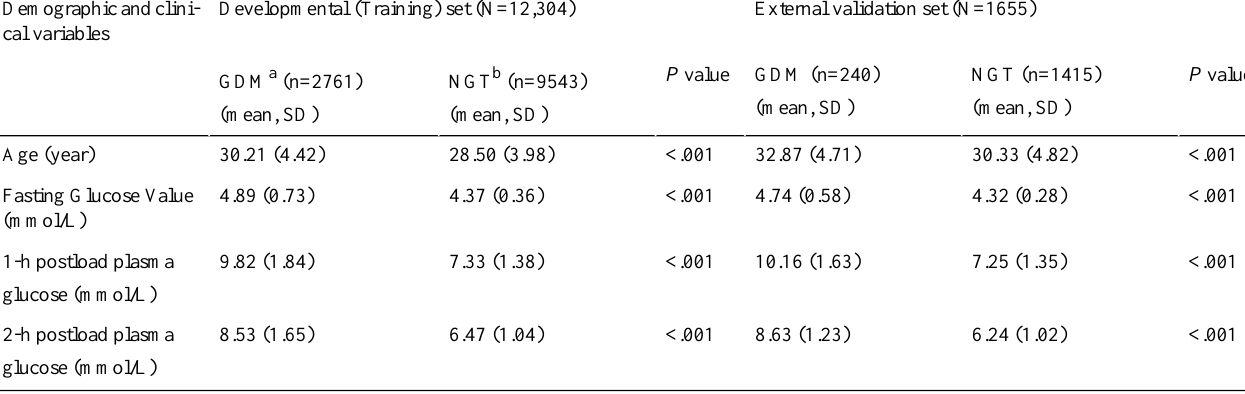
Table 1. Baseline